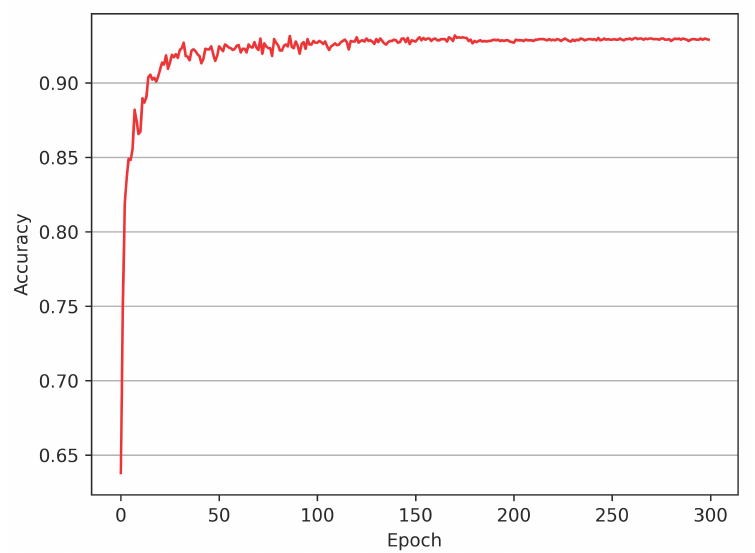
Figure 2. Accuracy curve (red) of the proposed model on the ModelNet40 classification task with an exponential decay learning schedule. Our model converges rapidly and